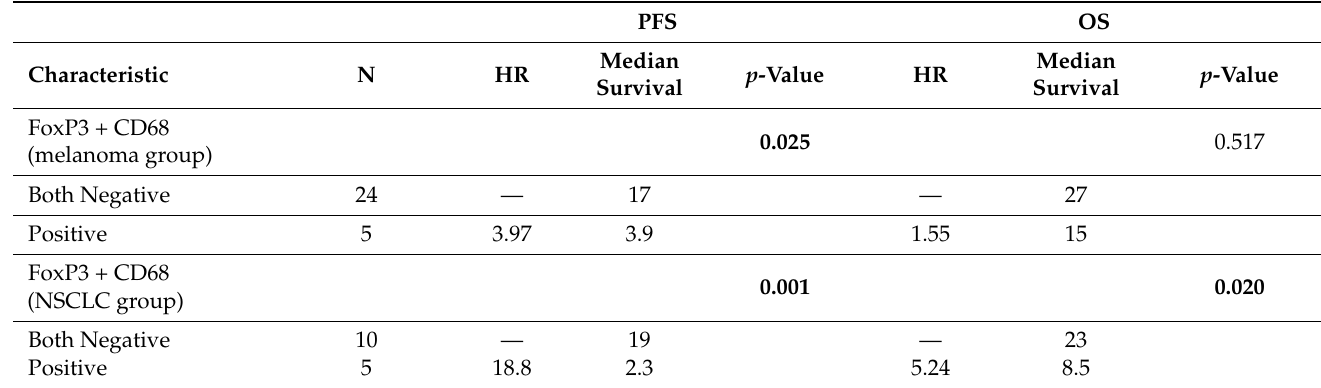
Table 7. Correlation between FoxP3 and CD68 expression and survival parameters.